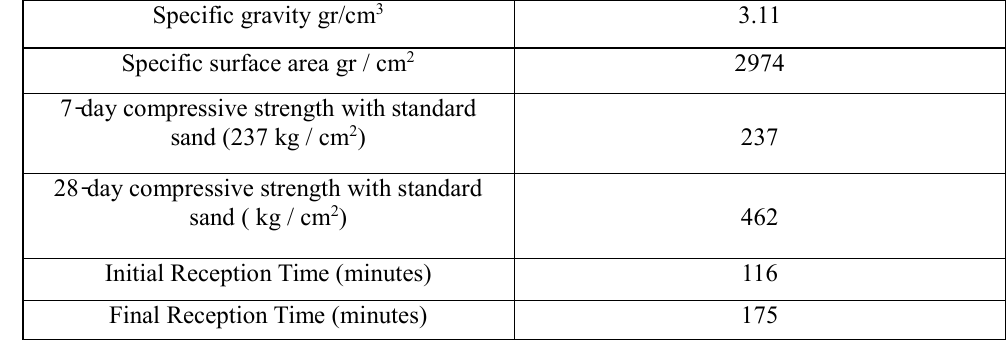
Results of Sufian Type 2 Cement Mechanical Experiments.